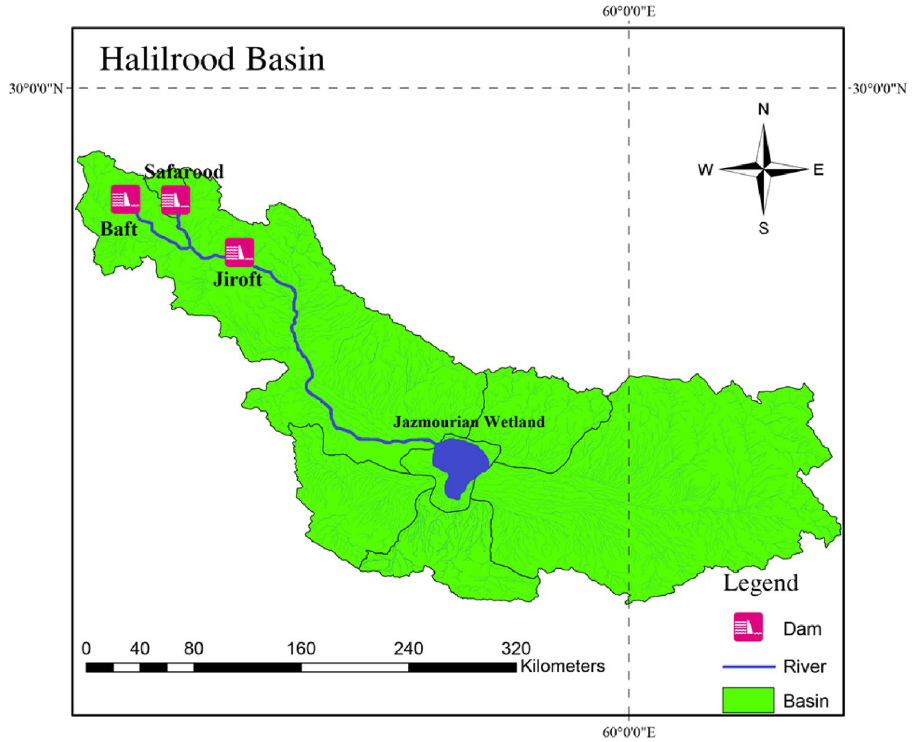
Figure 9. Location of Halilrood multi-reservoirs system. This figure was constructed by authors through version 10.2.2 of ArcGIS software (https:// www. arcgis. com).